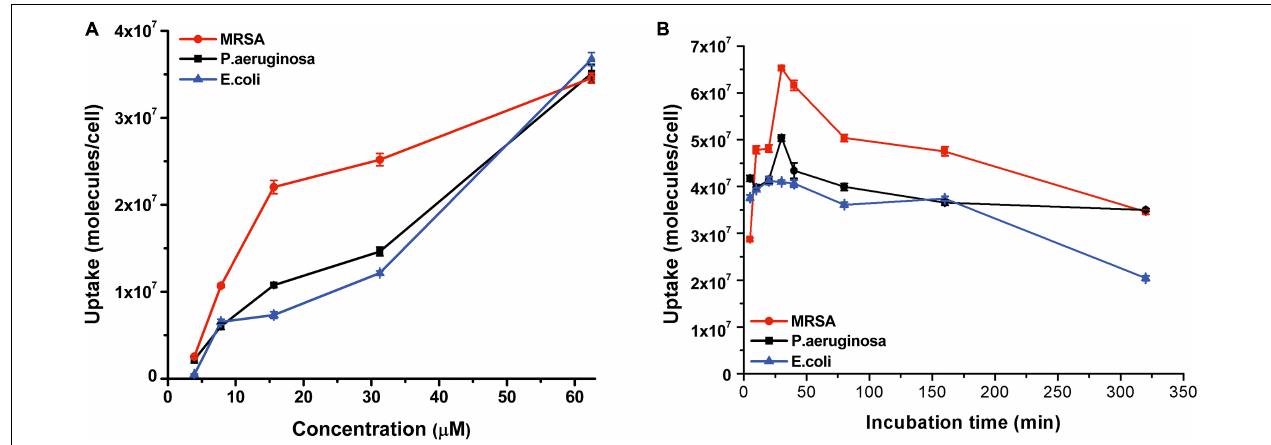
FIGURE 4 | PPIX-MED was taken up by three bacterial strains. (A) Bacterial culture was incubated with PPIX-MED (3.91–62.5 µ M) in the dark for 30 min at ambient temperature. (B) Bacterial culture was incubated with PPIX-MED (6.25 µ M) for 320 min.